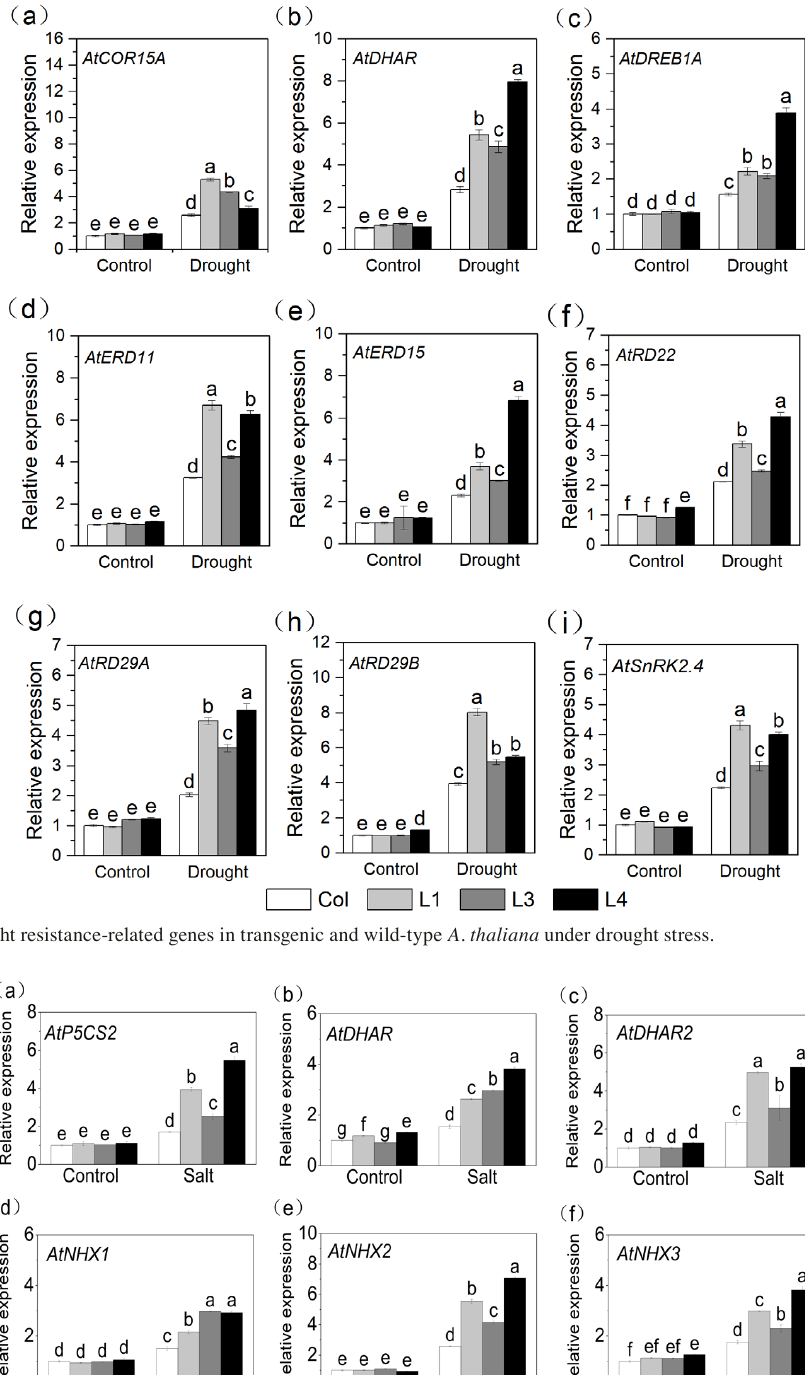
Fig. 9: Expression of salt tolerance-related genes in transgenic and wild-type A. thaliana under normal and salt stress